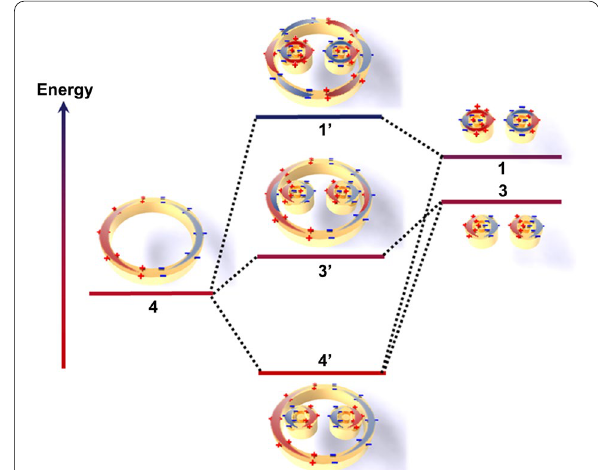
Fig. 3 Schematic of plasmonic hybridization between the dipolar mode of the wall ring structure and the hexapole mode of paired bull-eye rings, and the energy diagram of the degenerated plasmon bright and dark